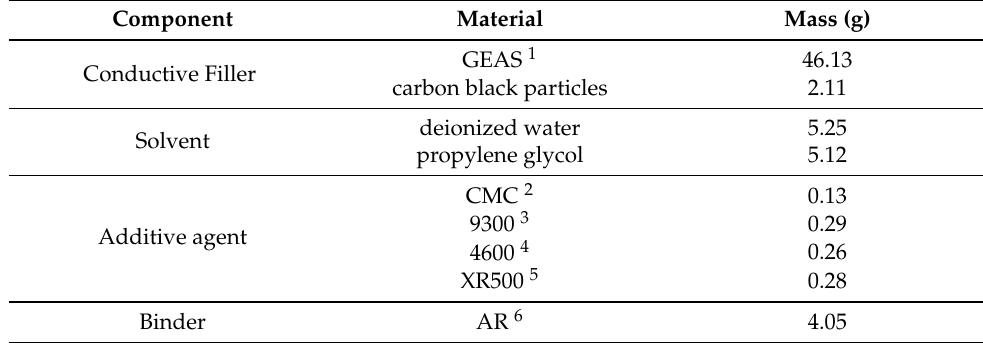
Table 2. The required materials to prepare graphene conducive ink for printing films with a sheet resistance of 400 Ω / (cid:3) .